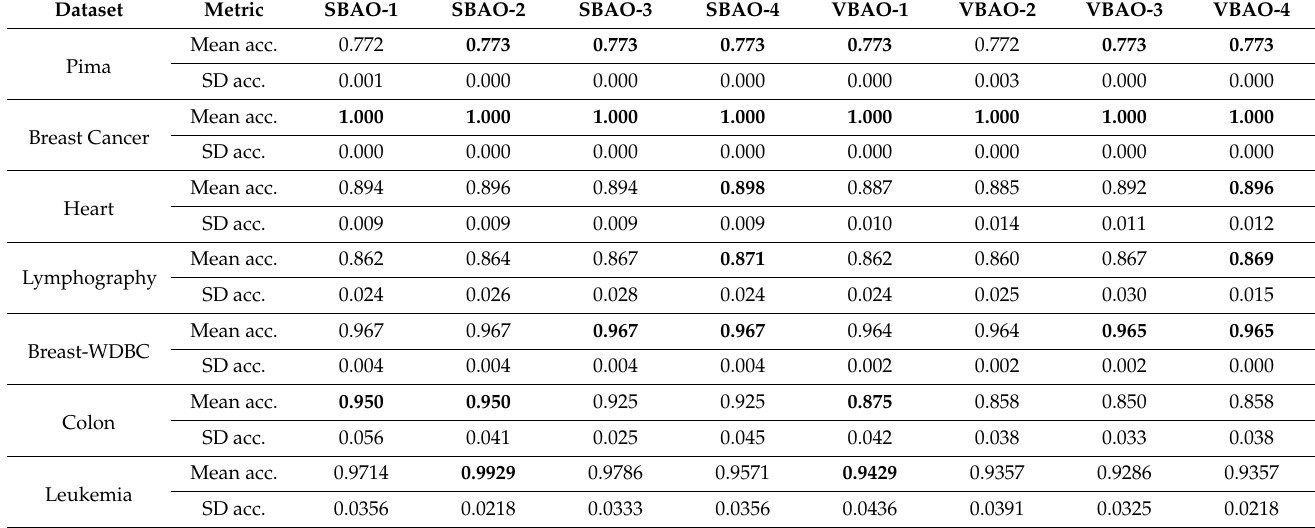
Table 4. The accuracy comparison of SBAO and